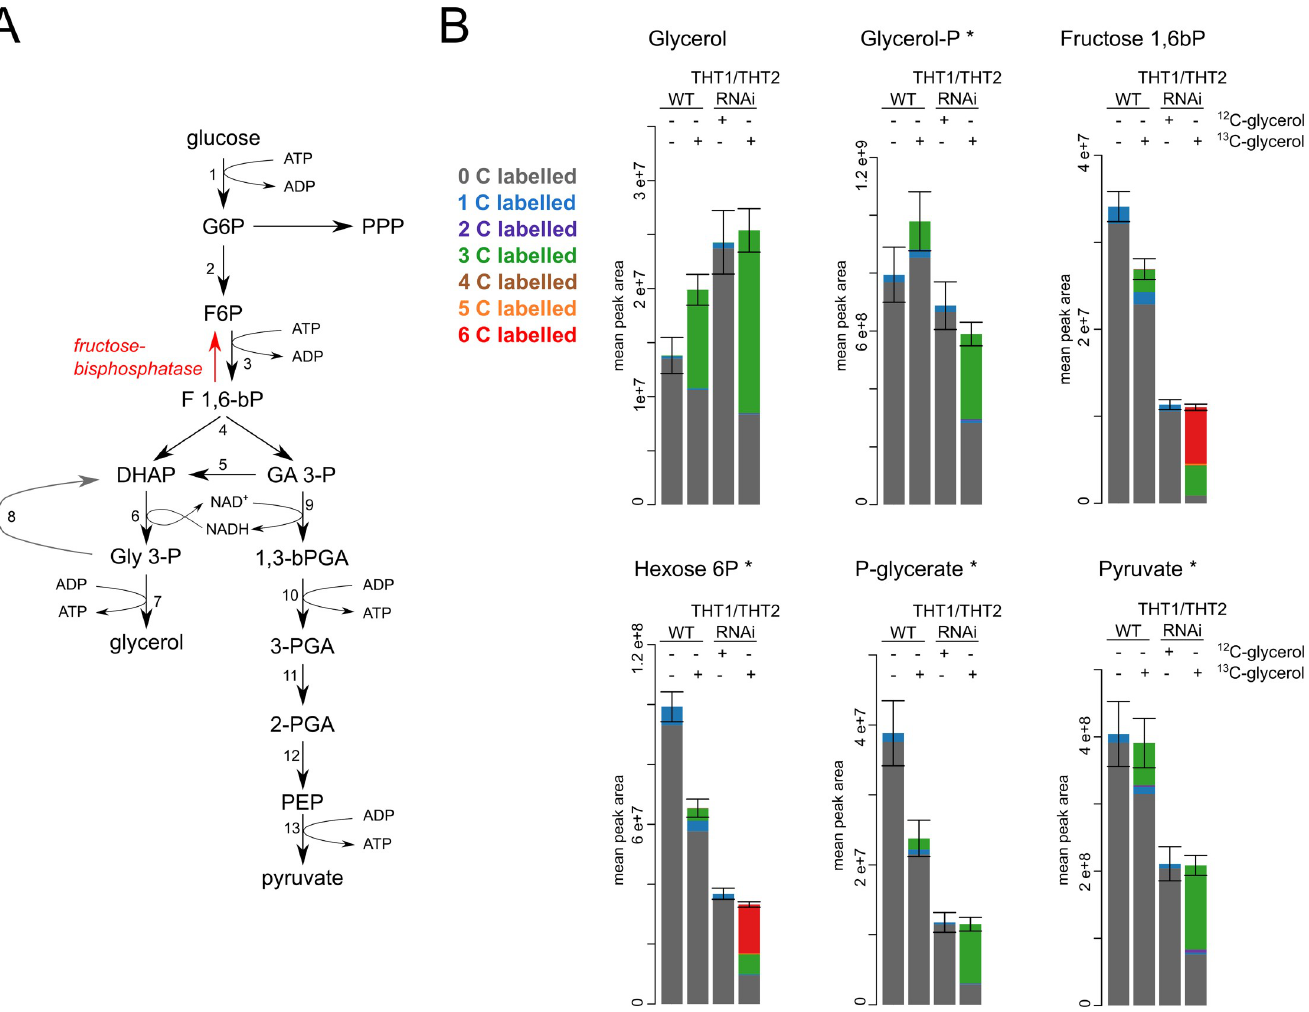
Fig 4. Gluconeogenesis in trypanosomes growing on glycerol. (A) A scheme of glycolysis and gluconeogenesis with highlighted fructose-1,6-bisphosphatase. PPP, pentose phosphate pathway; 1, hexokinase; 2 glucose-6-phosphate isomerase; 3, phosphofructokinase; 4, fructose-bisphosphate aldolase; 5, triose-phosphate isomerase; 6, glycerol-3-phosphate dehydrogenase; 7, glycerol kinase; 8, mitochondrial glycerol-3-phosphate dehydrogenase; 9, glyceraldehyde-3-phosphate dehydrogenase; 10, phosphoglycerate kinase; 11, phosphoglycerate mutase; 12, enolase; 13, pyruvate kinase. (B) Metabolites from glycolysis/gluconeogenesis as detected in the LC-MS analysis. The size of the bars represents the total abundance, and coloured parts indicate 13 C labelling as depicted in the key. The samples are from WT cells, WT grown in 13 C-glycerol, THT1/THT2 RNAi grown in 12 C-glycerol and THT1/THT2 RNAi grown in 13 C-glycerol. Glucose was also present for all experiments. Natural abundance of 13 C is 1%, hence the 1C labelling in ‘un-labelled’ samples that is proportional to the number of carbons in each metabolite. � identity of these metabolites was confirmed using a match with a standard.